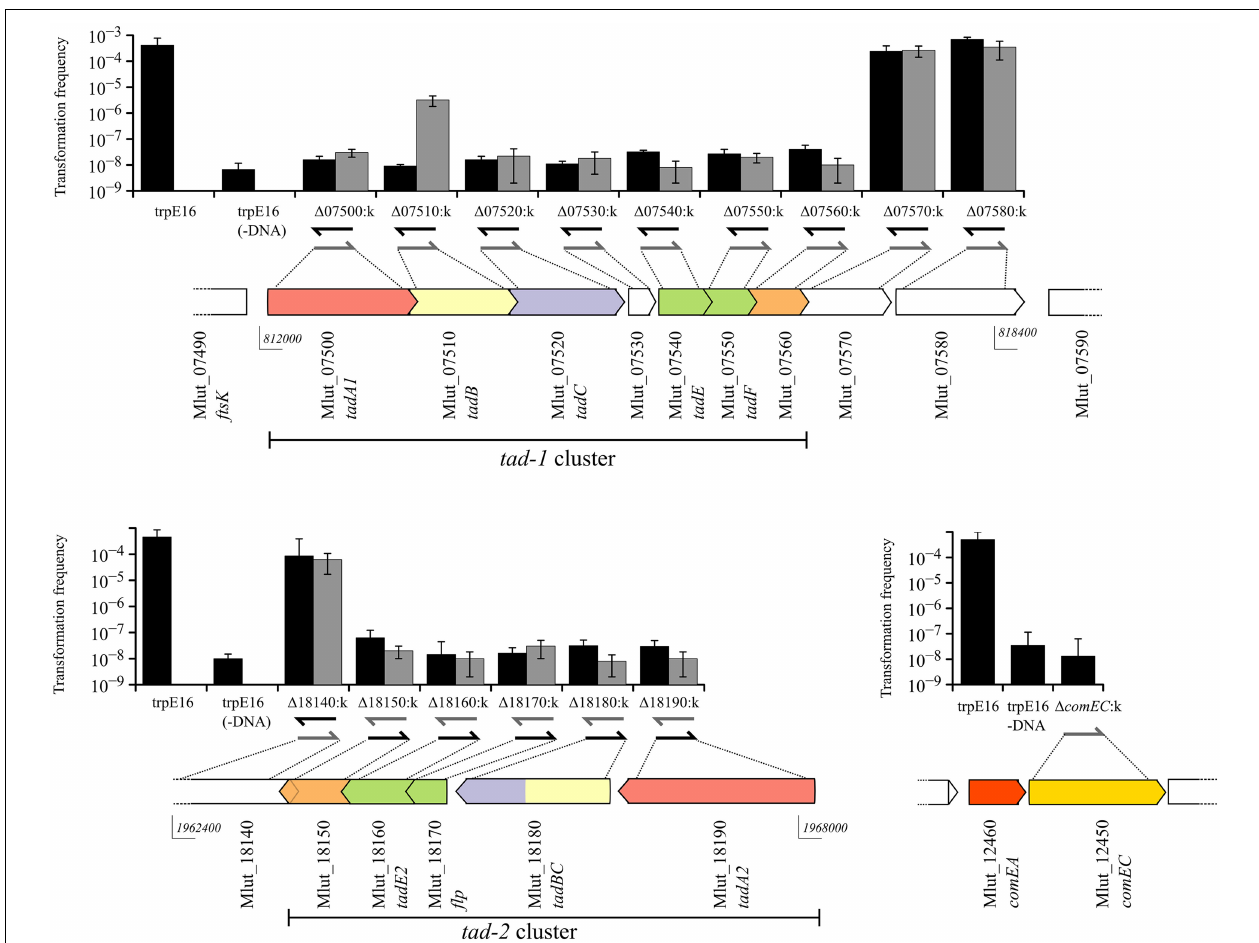
FIGURE 2 | Genetic organization of the two tad clusters and of the comEA/EC locus of M. luteus and transformation frequencies of the respective gene deletion mutants (gray bars for kanamycin gene insertion in the same orientation and black bars for insertion opposite to the respective ORF). The in silico predicted Flp and Flp-like genes are shown in green and the pili biogenesis genes in